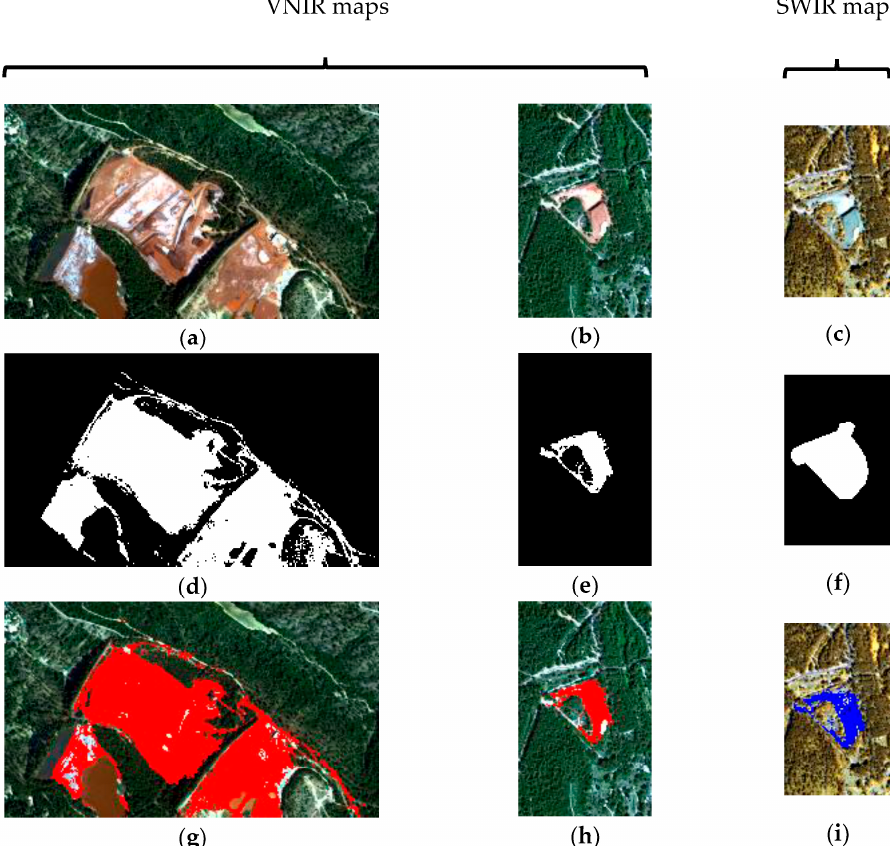
Figure 5. HySpex VNIR color composite ( a , b ) and masks used for the areas of interest ( d , e ). Map of bauxite and bauxaline ® based on band positions in the VNIR ( g , h ). HySpex SWIR color composite (R–1060 nm; G–1250 nm; B–1590 nm) of the bauxite and alumina stockpile ( c ); and corresponding mask ( f ). Map of bauxite and alumina based on band positions in the SWIR ( i ).